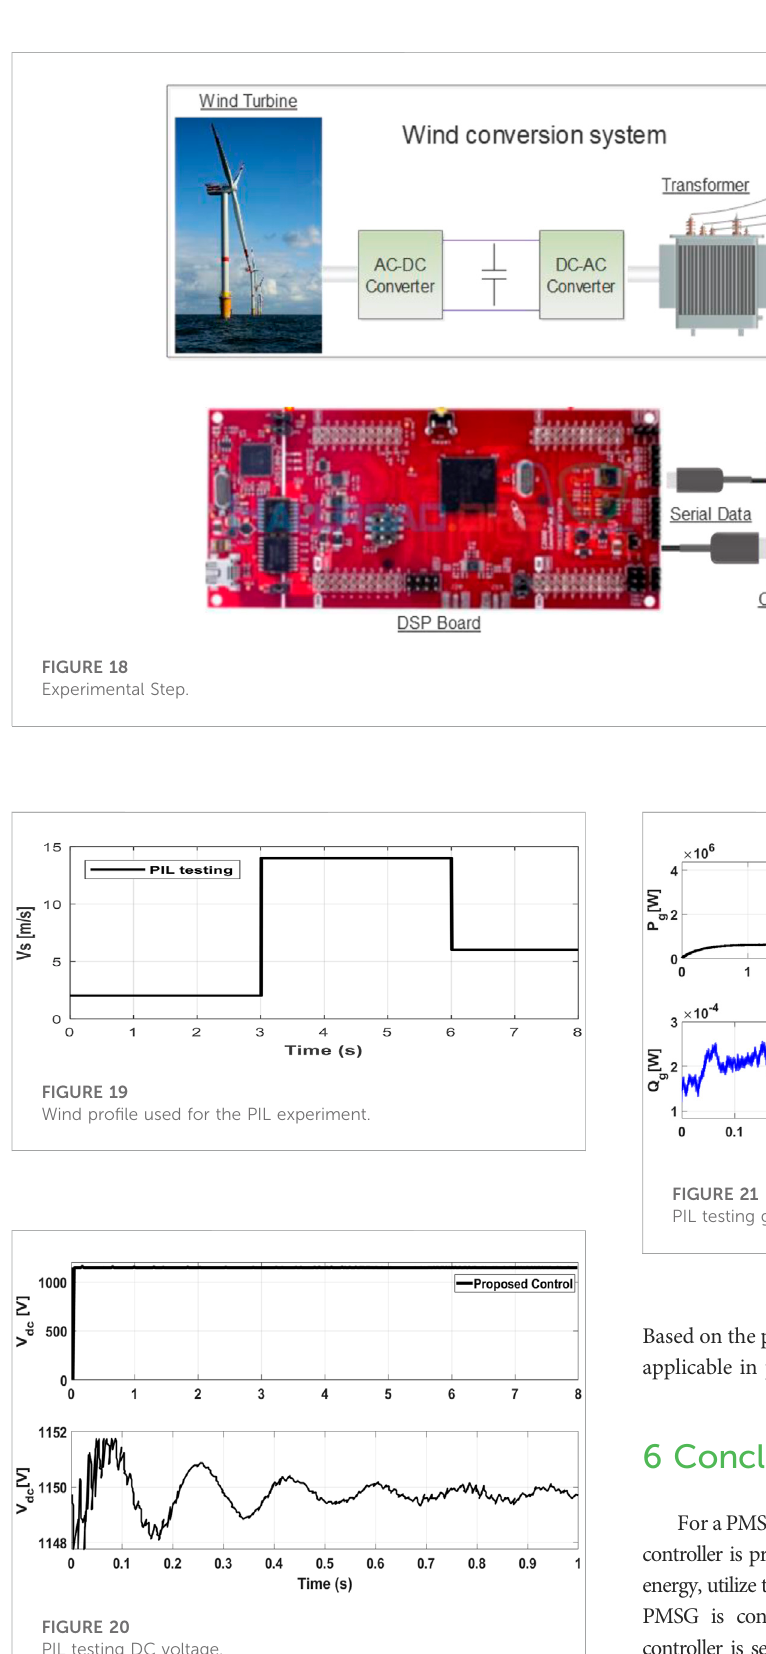
FIGURE 20 PIL testing DC voltage.